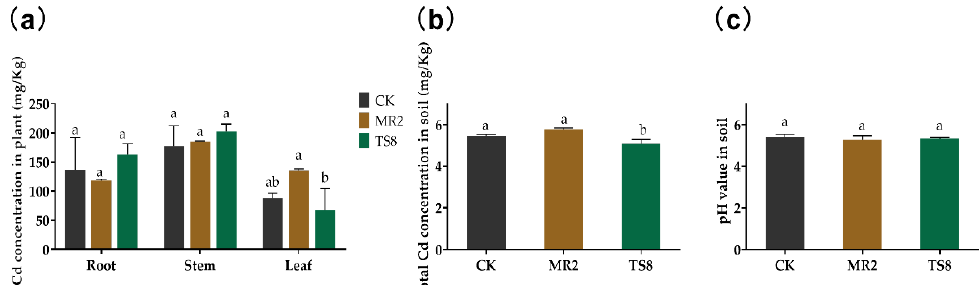
Figure 6. Cd concentration in plant tissues/soil and soil pH. ( a ) Effect of MR2 and TS8 inoculation on Cd uptake by M. floridulus root, stem, and leaf grown for two months in the contaminated soil. ( b ) Cd concentration in soil after phytoremediation. ( c ) pH value in soil after phytoremediation. The data were expressed as means ± standard deviation ( n = 3). Different letters represent significant differences between groups at the 5% level (ANOVA and Tukey’s test) .